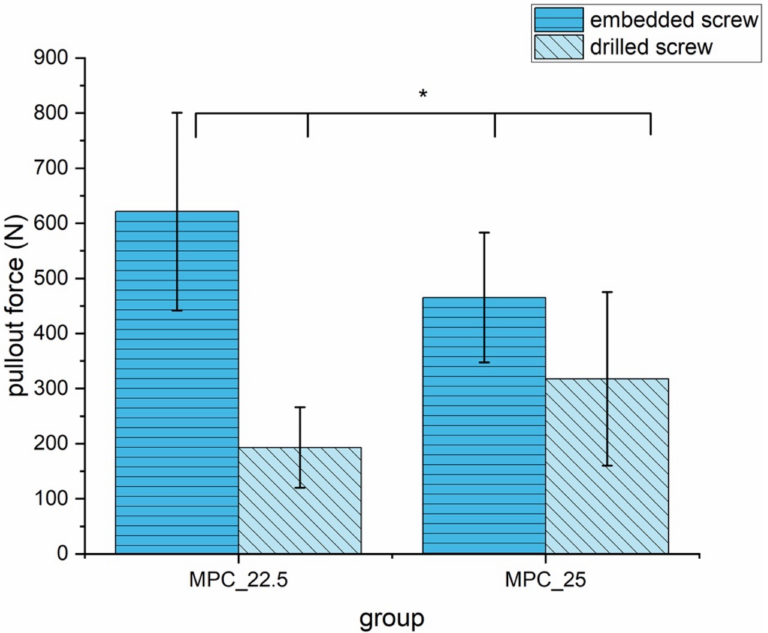
Figure 11. Pullout strength of the two MPC formulations with embedded and drilled screws. All differences were statistically significant with p < 0.05 (marked with an asterisk